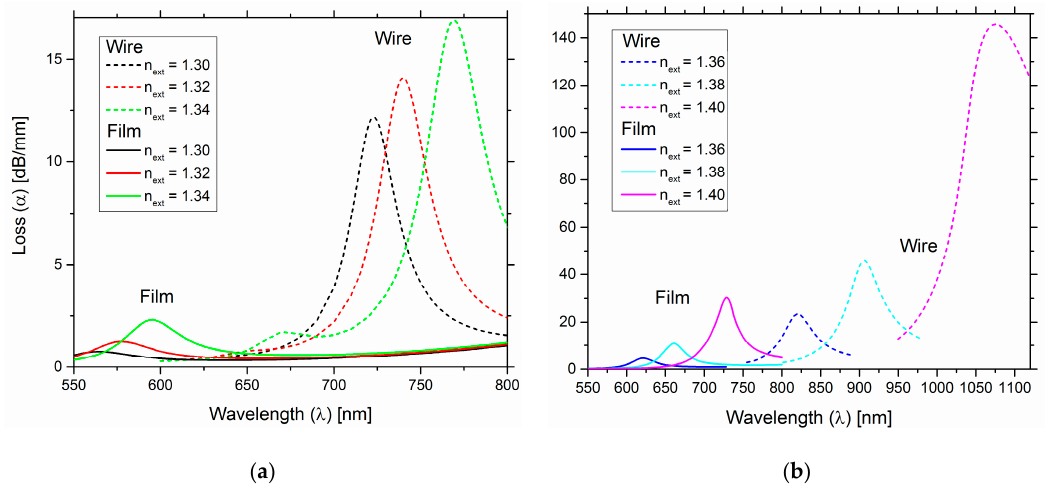
Figure 6. Loss curves versus wavelength comparison for two configurations, one for the metal nanowire and another for the more conventional configuration with a metal film, for two ranges of n ext = [1.30–1.34] ( a ) and n ext = [1.36–1.40] ( b ), respectively. Table 2. Comparison of the sensitivity and resolution for the two structures, one with metallic film and the other one with the metallic wire. Sensitivity (nm/RIU) Resolution (RIU) Range of n ext